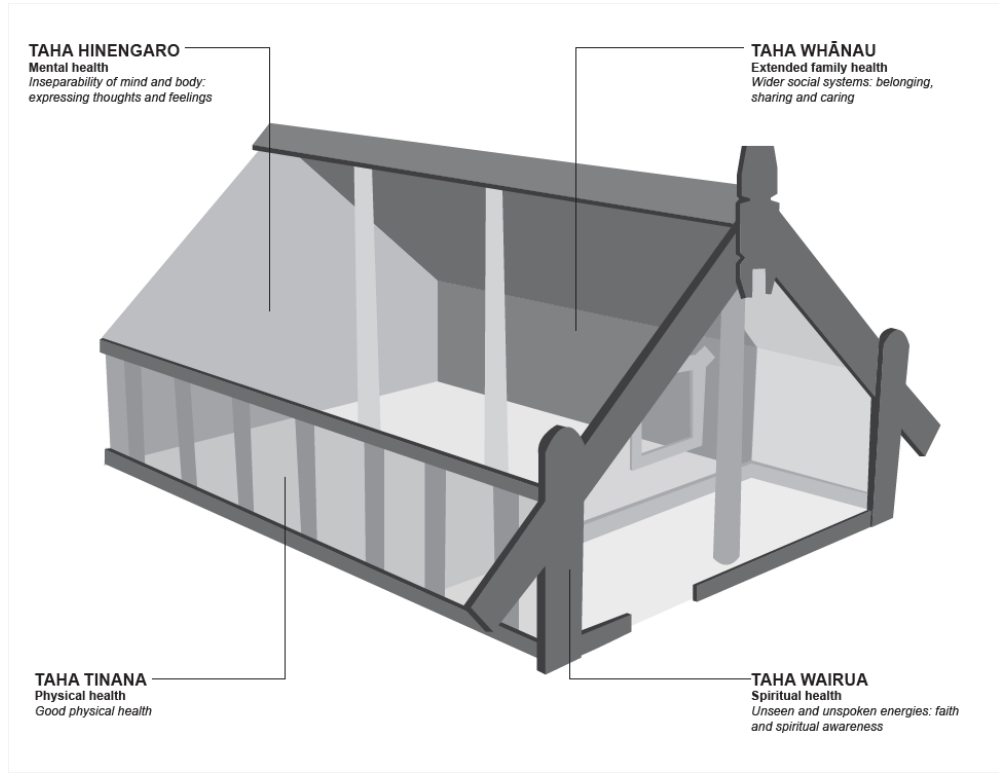
Figure 1. Te Whare Tapa Whā. Source: Redrawn from Durie M. 1994. Whaiora, Maori Health Development. Auckland: Oxford University Press.